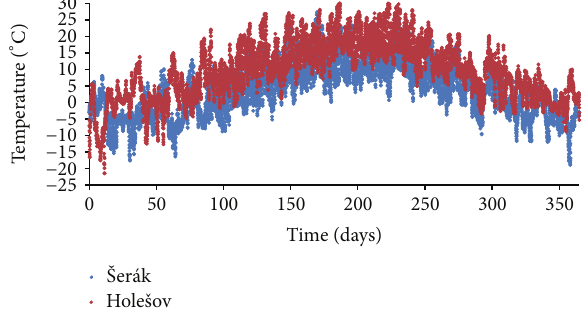
Figure 4: A comparison of reference-year temperatures for ˇSer´ak and Holeˇsov.